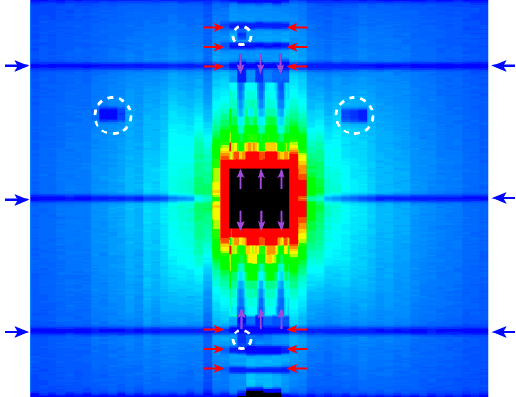
Figure 7. Two-dimensional distribution of scattered neutron counts on the area detector (real-space histogram), which was covered with the cadmium mask plate. The calibrated correction factors ( a i , b i , and c i ) were applied at the data processing. The pixel color indicates the neutron count rate, with red as maximum and blue as minimum. The red, purple, and blue arrows indicate the positions of the cadmium mask strips for the first, second, and third layer PSDs, respectively. The white dashed circles indicate other cadmium pieces placed asymmetrically in order to check the overall PSD orientation.